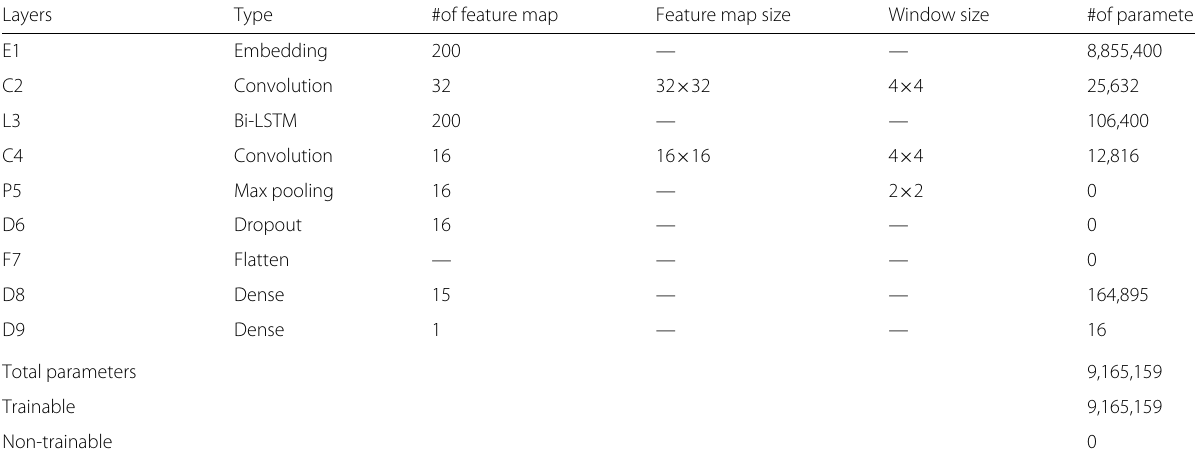
Table 3 Structure of our proposed model